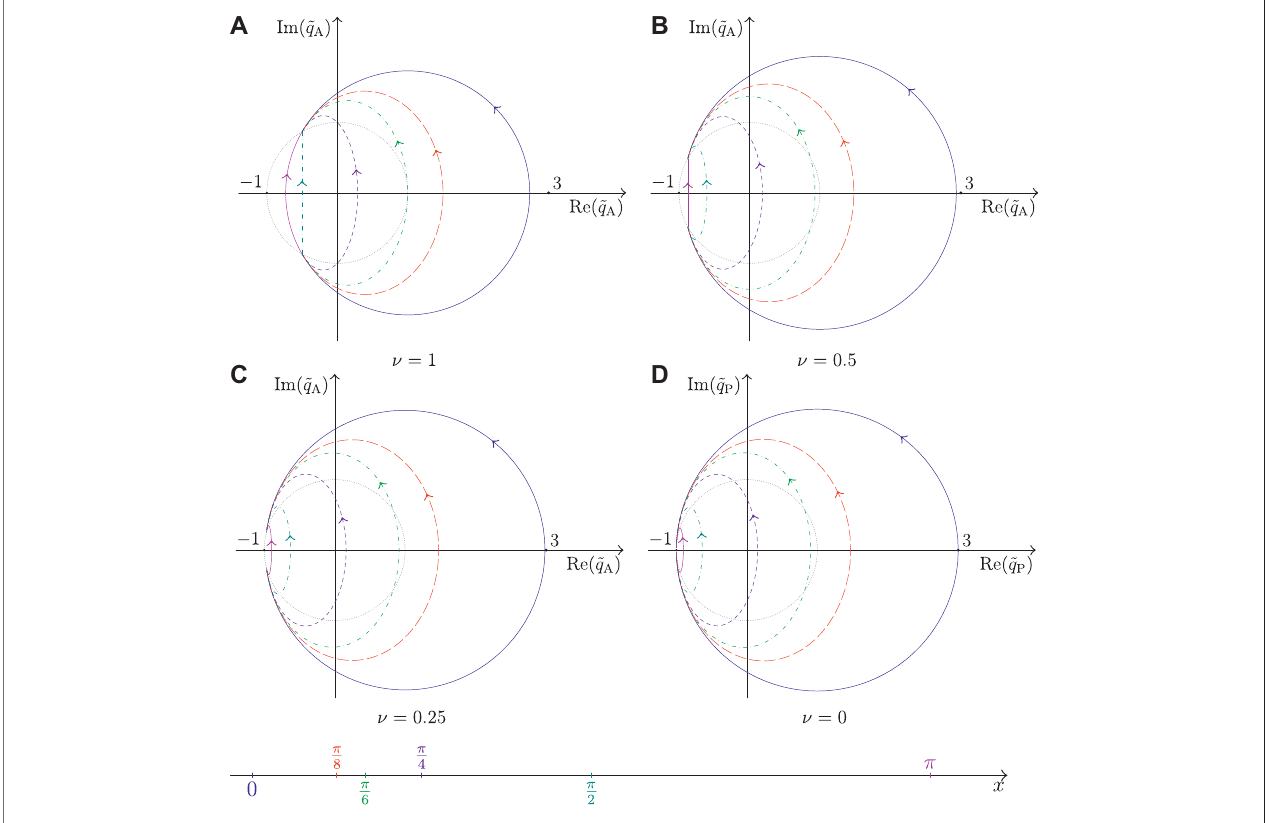
FIGURE 7 | Parameterization of the non-rapid oscillating complex-valued amplitude ~ q in the temporal variable t (− ∞ < t < ∞ ) for different values of spatial variable x : x (cid:2) 0 (solid blue), x (cid:2) π / 8 (long-dashed red), x (cid:2) π / 6 (dash-dotted green), x (cid:2) π / 4 (dashed purple), x (cid:2) π / 2 (dash-dotted cyan), and x (cid:2) π (solid magenta), and modulation frequencies of the Akhmediev solitons (A) ] (cid:2) 1, (B) ] (cid:2) 0 . 5, (C) ] (cid:2) 0 . 25, and (D) ] → 0 (the Peregrine soliton).